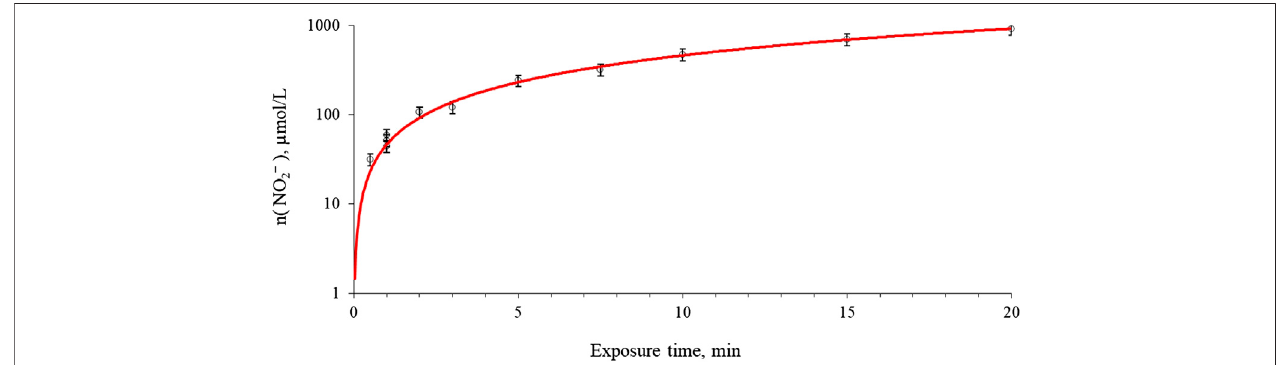
(Figure 11) envisages a pulsed intrasoil discrete injection of liquid biological drug based on CAP activated water (1, 3). Pulsed intrasoil discrete watering with CAP activated water (4) follows drug injection. The robotic system comprises energy supply unit (5), positioning and control unit (6), liquid biological drug source (7), and piezoelectric direct discharge CAP induced PAW source (8).